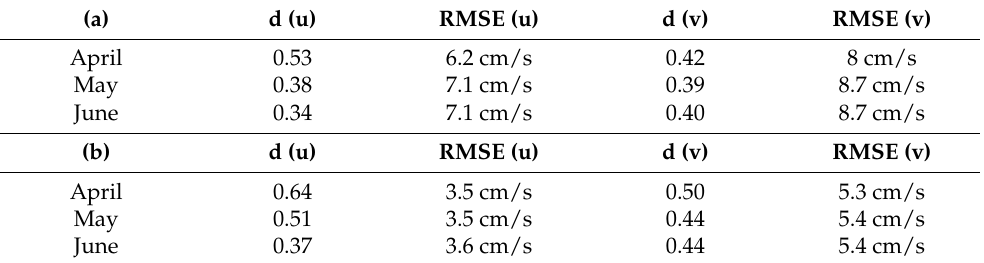
Table 14. Model skill score and RMSE between simulated and observed sea surface